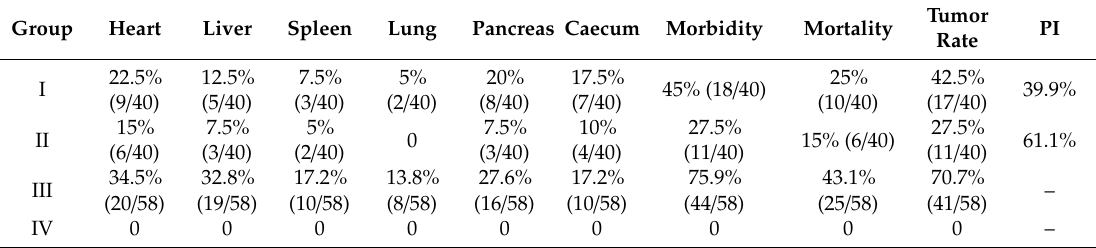
Figure 5. Survival patterns showing the overall effects of the various treatments. Table 3. The disease incidences of the birds challenged with the GX18NNM4